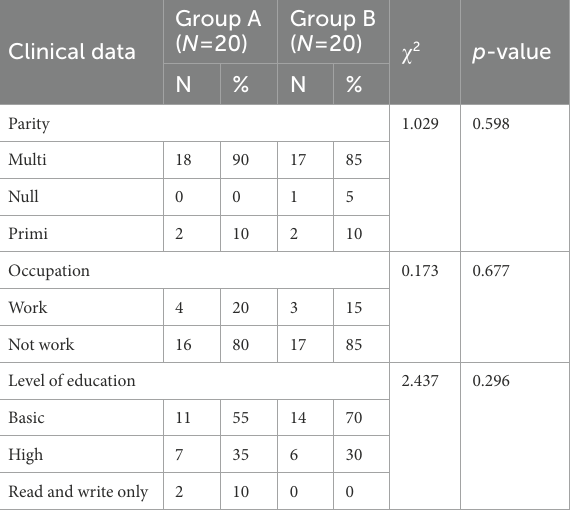
TABLE 2 Clinical data of the Studied Groups (A and B).